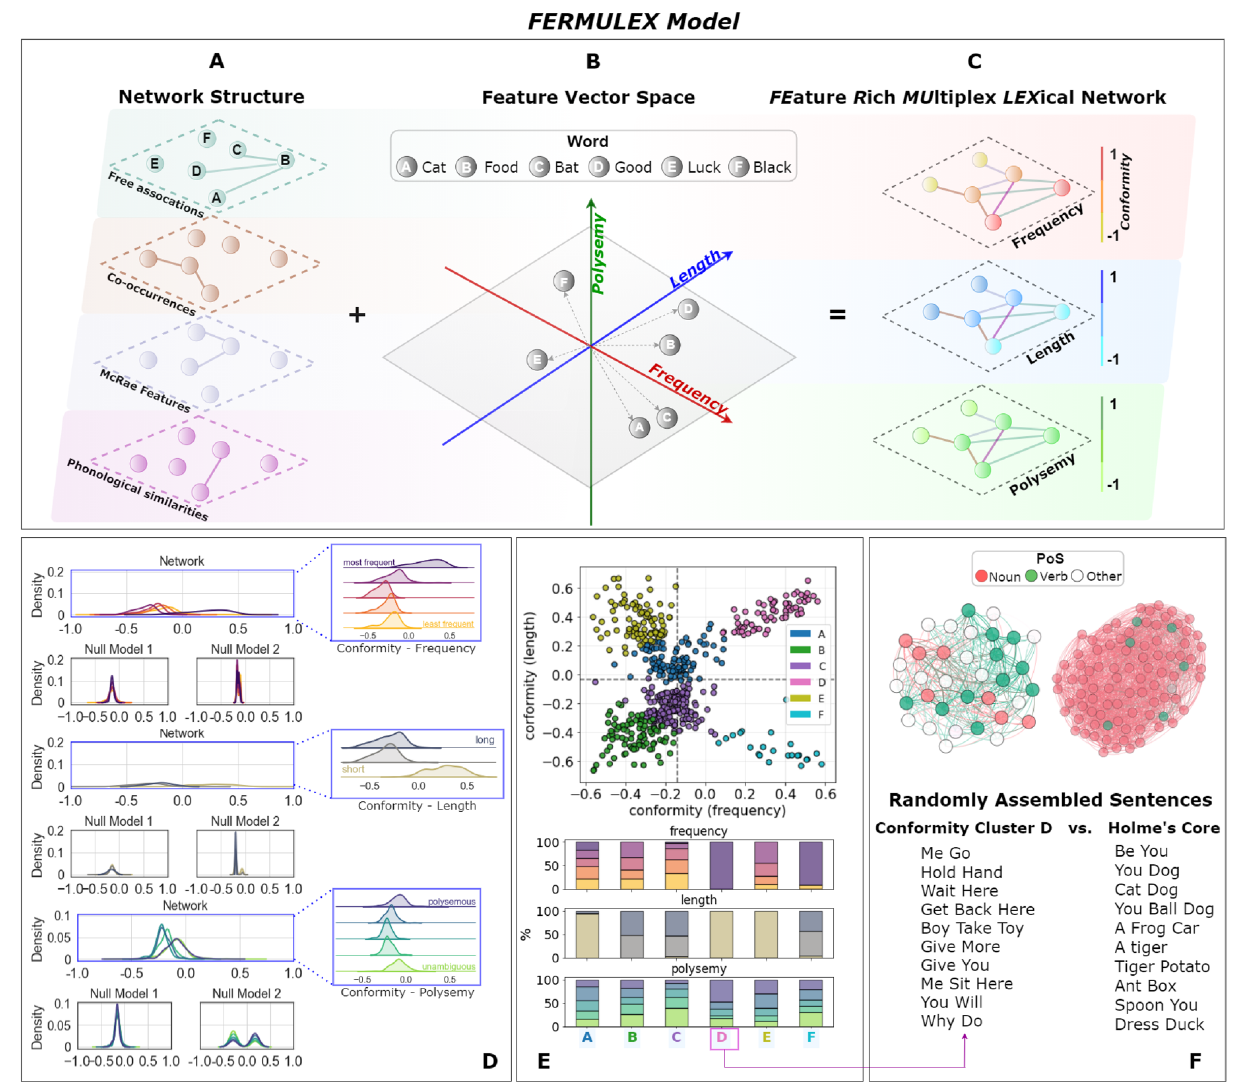
Figure 1. ( A – C ) Combining multiplex topology ( A ) and vector spaces ( B ) results in FERMULEX network ( C ); ( D ) kernel density estimates (KDEs) and ridgeline plots highlight conformity distribution for the frequency, length, and polysemy features in toddlers’ mental lexicon and the randomised variants; ( E ) Above—two- dimensional scatter plot of conformity vector space, where each point is colored according to the cluster the point belongs to (K-means algorithm); Below—distribution of word features within each cluster, where a kernel language emerges, i.e. the cluster labeled as D ; ( F ) content characterisation of the kernel compared to a competitor from a k-core